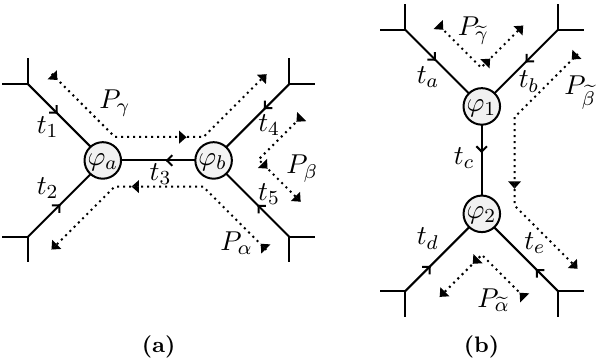
Figure 15. Two dual sub-graphs of a cubic graph. We can (cid:12)nd the relationship between the two sets of supermoduli ( t 1 ; : : : ; t 5 j ’ a ; ’ b for (cid:12)gure 15a and t a ; : : : ; t e j ’ 1 ; ’ 2 for (cid:12)gure 15b) by identifying the corresponding paths as described in the